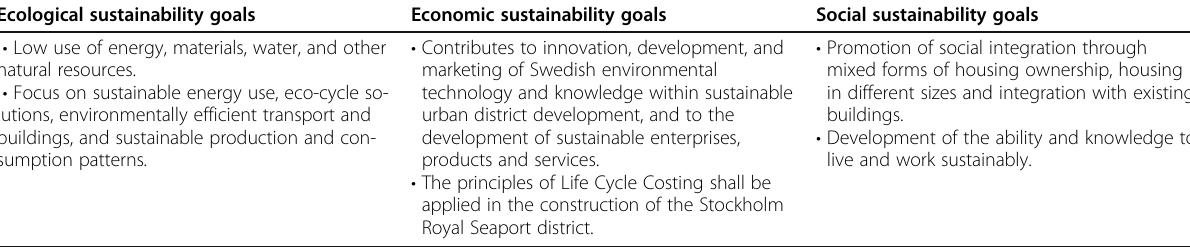
Table 6 Some examples of three sustainability goals of SRS program Ecological sustainability